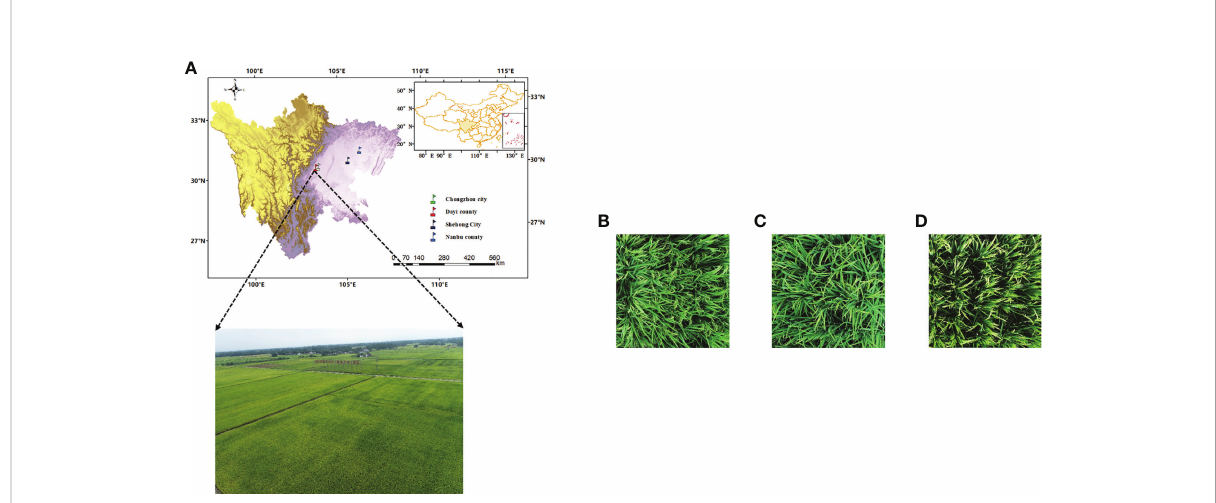
FIGURE 1 Experimental site and photos of different types of rice panicles. Experimental site of Dayi County (A-D) represent spike above leaf, leaf above spikes, and middle type,